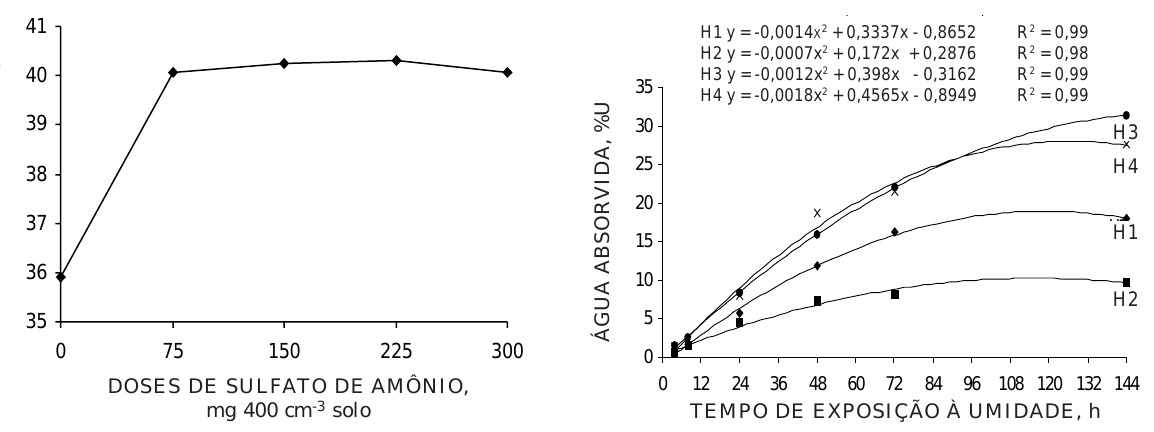
Figura 3. Valores obtidos para ângulo de repouso, considerando a dose de sulfato de amônio presente na mistura de fertilizantes.